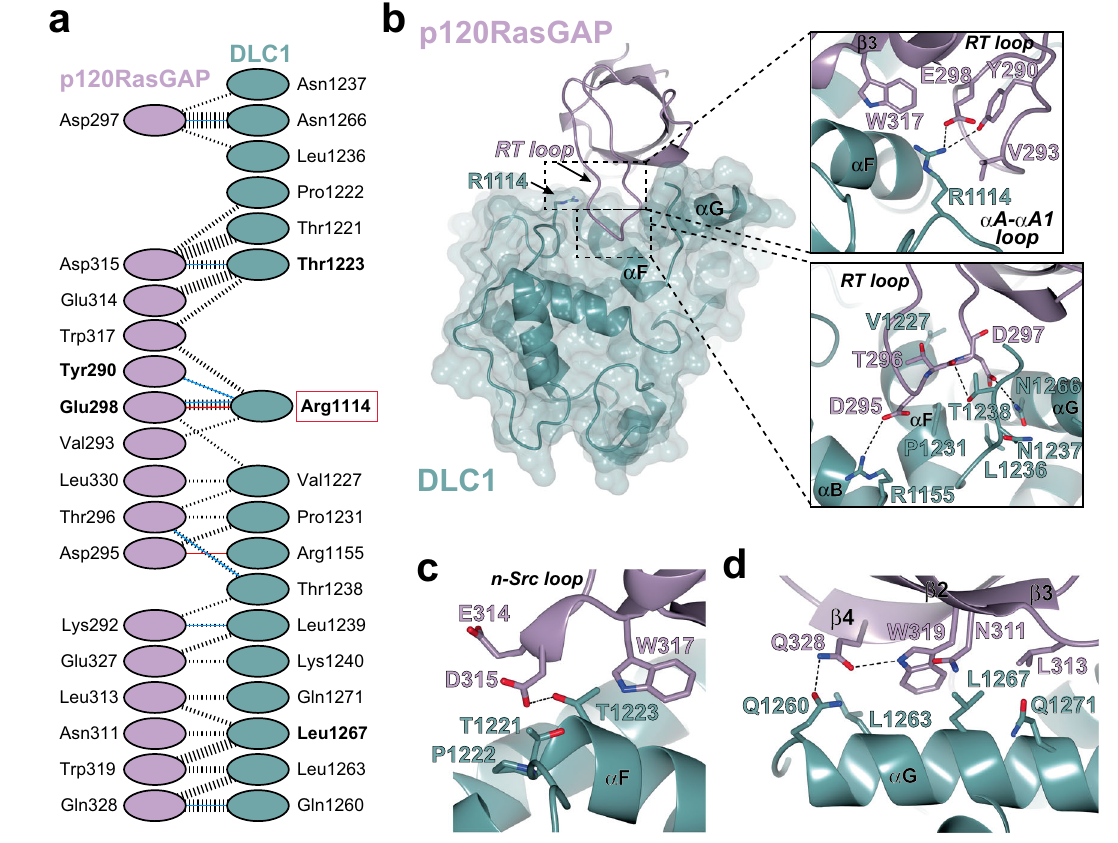
Fig. 2 | Details of interface between DLC1 and p120RasGAP. a Residue interac- tionsadaptedfromPDBSum 86 andPISAserver 44 .Bluelineindicateshydrogenbond, redlineindicatessaltbridge.Thewidthoftheblackdashedlinesisproportionalto thenumberofnon-bondedatomiccontactsascalculatedinPDBSum 86 .SH3domain